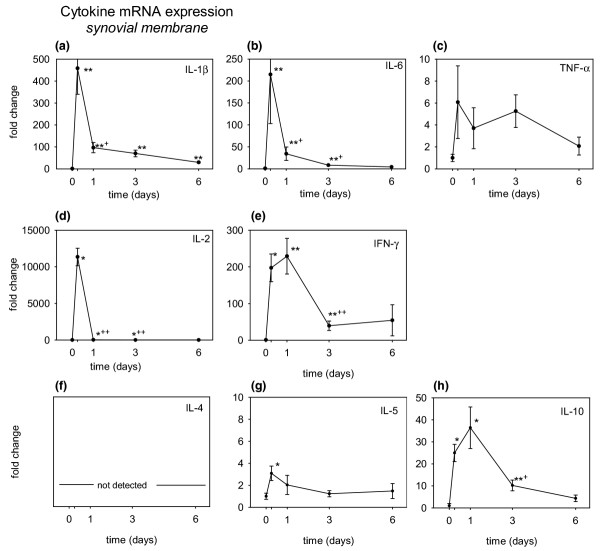
Expression of mRNA of various cytokines in the synovial membrane of rats with AIA. Expression of mRNA was assessed before the induction of antigen-induced arthritis (AIA) (day 0) or afterwards (at 6 hours and on days 1, 3, and 6). Data were originally expressed as arbitrary units (1 unit = highest detectable dilution of the competitor fragment) and then related to the value of day 0 (fold change). Values are means;vertical bars indicate the standard error of the mean (n = 4 to 6 rats for each time point). Each determination was performed in duplicate. *P ≤ 0.05, **P ≤ 0.01 in comparison with day 0; +P ≤ 0.05, ++P ≤ 0.01 in comparison with the preceding date.